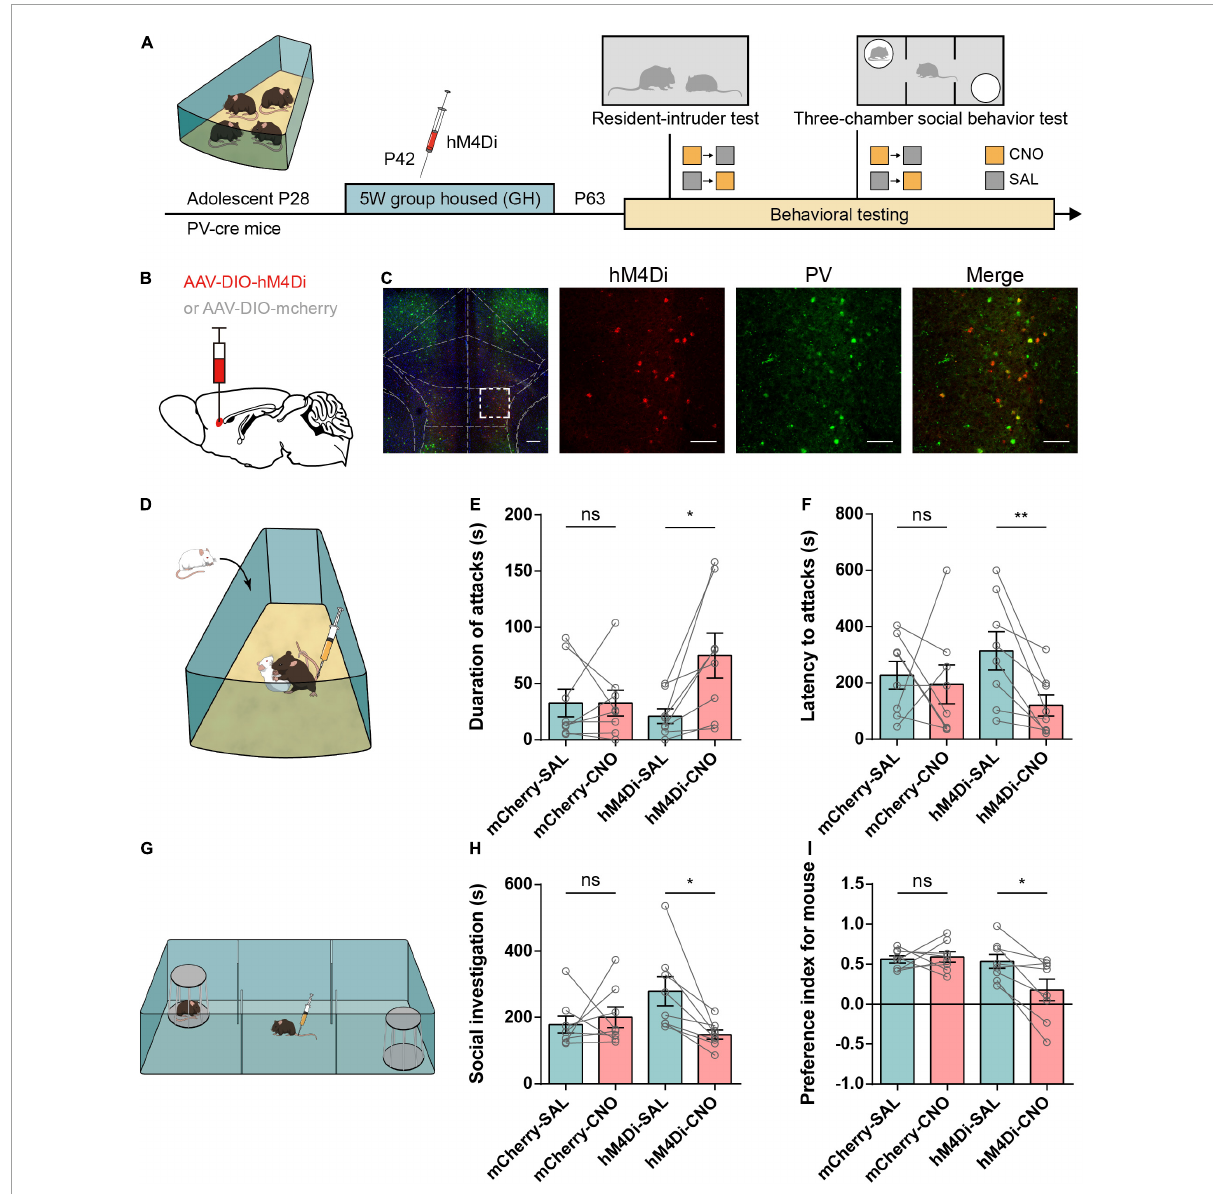
FIGURE4 Chemogenetic inhibition of IL-PV interneurons increases aggressive behaviors and disrupts social preference in group-housed mice. (A) Timeline showing injection of the Cre-dependent inhibitory virus hM4Di or mCherry into the IL of group-housed PV-Cre mice and the subsequent repeated behavioral tests. Every mouse was tested under both CNO (yellow square) and SAL (gray square) conditions, and each behavioral test was counterbalanced by the order of the injections. (B) Strategy of specifically expressing inhibitory G-protein (Gi)-coupled hM4Di receptor or mCherry in PV + interneurons. (C) Representative images of inhibitory hM4Di preferentially injected into IL-PV + interneurons (left, scale bar, 200 µ m) and colocalization of hM4Di virus expression (red) with PV staining (green) (right, scale bar, 100 µ m). (D) Experimental scheme for inhibiting hM4Di expression in IL-PV + interneurons 30 min before the resident-intruder test. (E) In the GH group, CNO treatment of hM4Di mice but not SAL promoted increased aggression, and mCherry mice showed no substantial changes under either the SAL or CNO condition ( n = 8 mice/group, mCherry, SAL, 32.81 ± 12.29, CNO, 32.75 ± 11.55, P = 0.94 obtained by two-tailed Wilcoxon matched-pairs signed rank test; hM4Di, SAL, 21.13 ± 6.52, CNO, 74.94 ± 19.99, P < 0.05 obtained by two-tailed paired t tests). (F) Only GH mice expressing hM4Di under CNO conditions showed a reduced latency to attack, and mCherry mice or hM4Di mice injected with SAL showed no substantial changes ( n = 8 mice/group, two-tailed paired t test: mCherry, SAL, 227.4 ± 49.25, CNO, 194.9 ± 68.89, P = 0.74; hM4Di, SAL, 313.9 ± 68.13, CNO, 119.7 ± 37.65, P < 0.01). (G) Mice were injected with either 3 mg/kg CNO or SAL 30 min before the 3-chamber social behavior tests. (H) Bar graphs showing that inactivation of the IL-PV + interneurons decreased the time spent in social investigation ( n = 8 mice/group, mCherry, SAL, 178.3 ± 25.60, CNO, 200.4 ± 30.93, P = 0.64 obtained by two-tailed Wilcoxon matched-pairs signed rank test; hM4Di, SAL, 279.0 ± 44.14, CNO, 147.9 ± 13.84, P < 0.05 obtained by two-tailed paired t tests). (I) Inactivation of IL-PV + interneurons decreased the social preference index of GH mice ( n = 8 mice/group, two-tailed paired t tests: mCherry, SAL, 0.56 ± 0.04, CNO, 0.59 ± 0.06, P = 0.74; hM4Di, SAL, 0.53 ± 0.09, CNO, 0.18 ± 0.14, P <